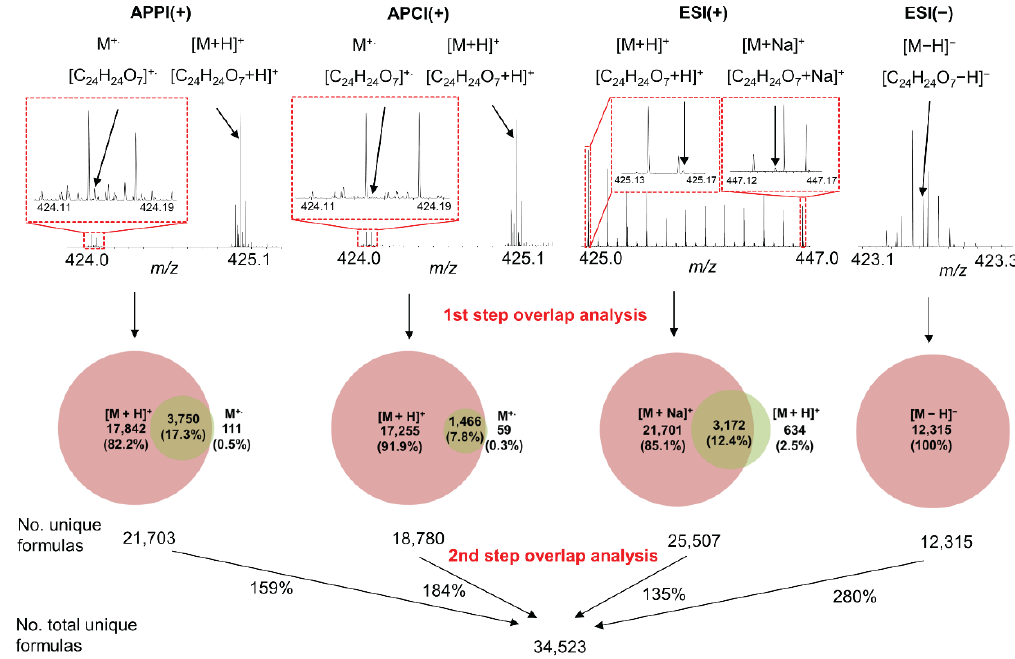
Figure 5. Two-step procedure to remove elemental composition replicates. The first step is to achieve the number of unique formulas in a single ionization technique. An example using the composition of C 24 H 24 O 7 , which can be detected in multiple forms depending on the applied ionization technique, is shown in mass spectra. The second step is to remove composition replicates among multiple ionization techniques, to obtain a total number of unique formulas.